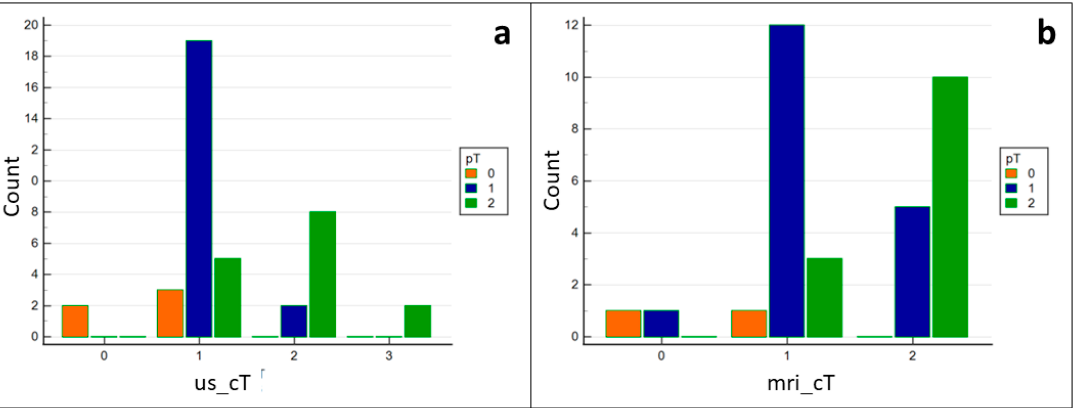
Figure 5. Frequency charts for clinically and pathologically derived T stage. ( a ) = us-derived and pathologically derived T stage. ( b ) = mri-derived and pathologically derived T stage.